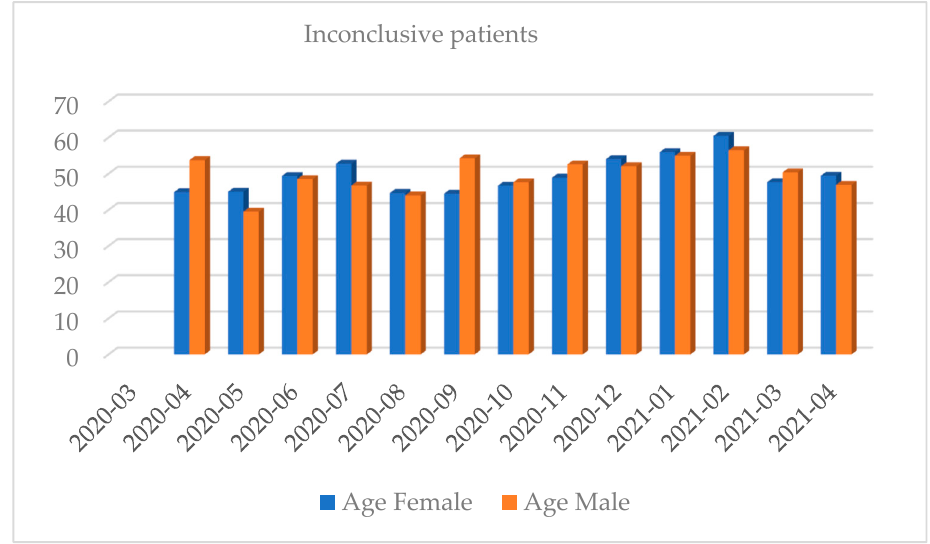
Table 2. Patients according to long-lasting symptoms.